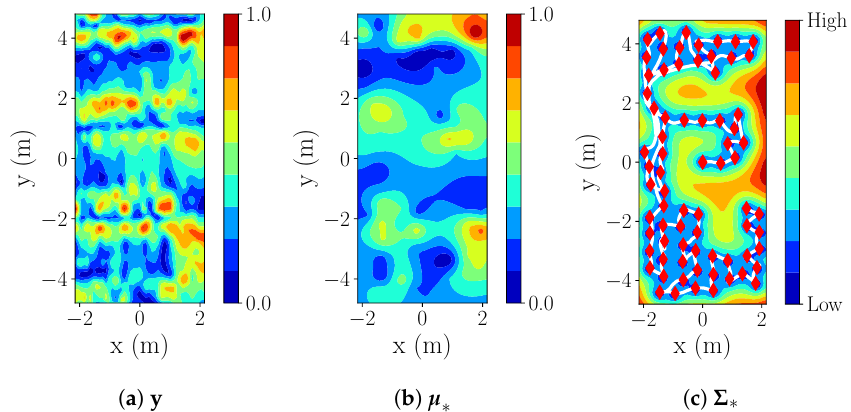
Figure 16. E1: IE, r = 3 m , k = 3 l with red diamonds in (c) representing measurements and white lines